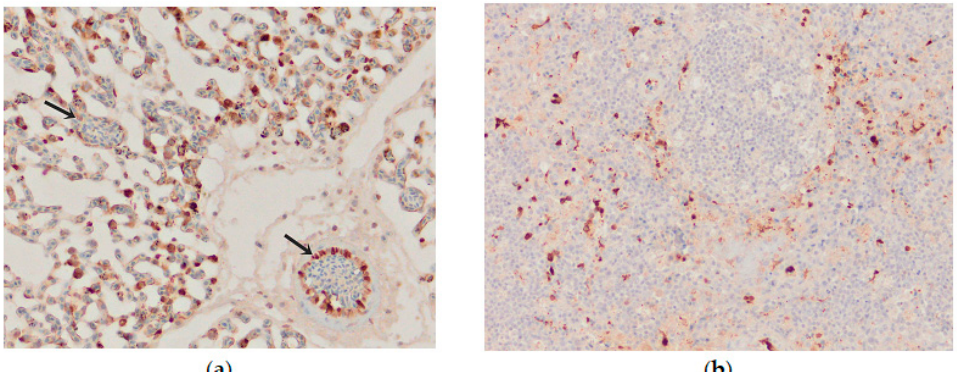
Figure 9. Immunohistochemical distribution of influenza viral nucleoprotein antigen in the tissues of chickens infected with H5N8 HPAI. ( a ) Lungs. Macrophages and epithelial cells of the lung interstitium, and vascular endothelial cells (arrows) positive for AIV antigen, bar × 400. ( b ) Spleen, AIV nucleoprotein in the vascular endothelial and inflammatory cells, bar × 100.